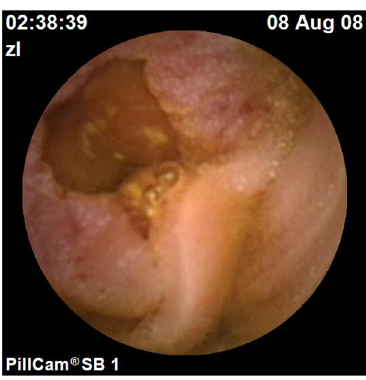
Figure 6. Multiple congestion and ulcers identified by CE. Multiple congestion and ulcers in the small bowel were identified by CE in a 17-year-old man with recurrent abdominal pain.